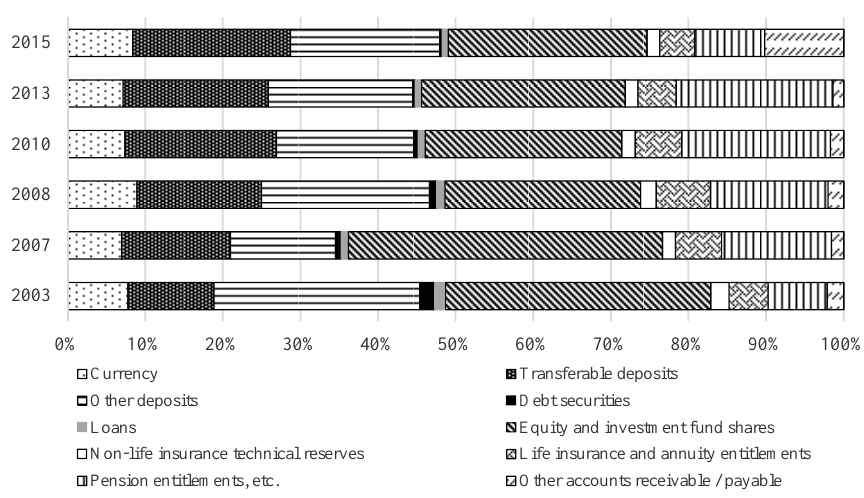
Figure 1. Structure of financial assets of the household sector in Poland in selected years of the period